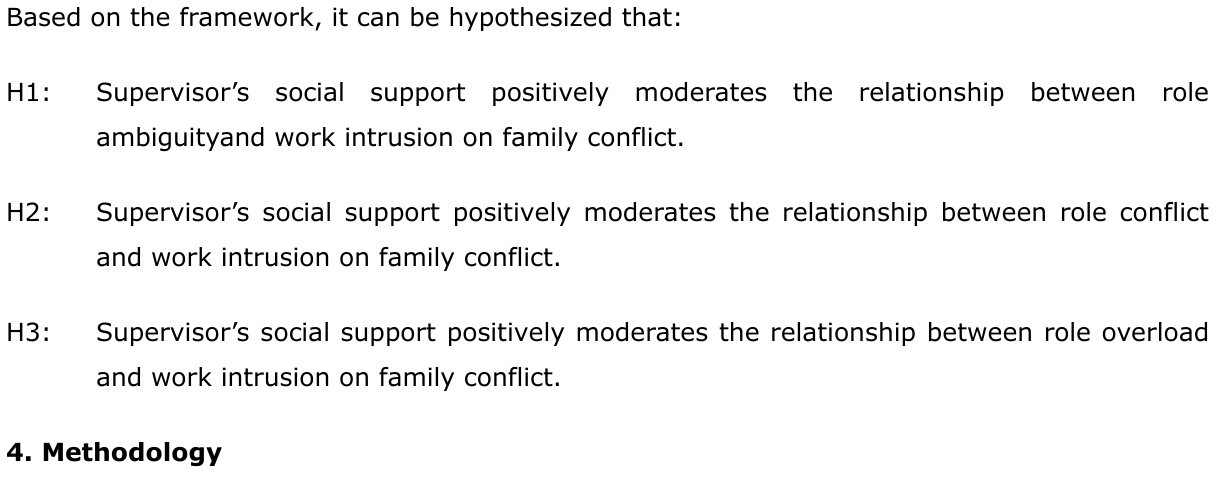
Figure 1. Conceptual